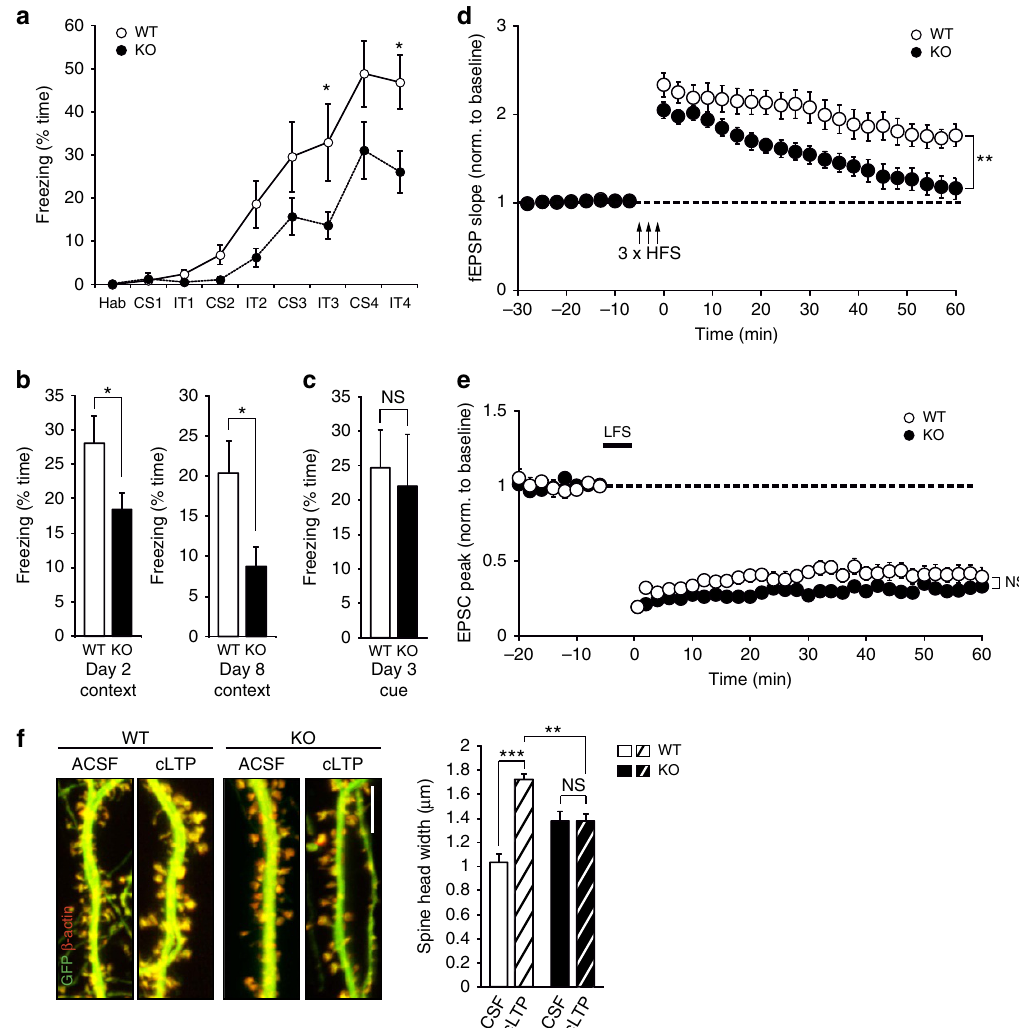
Figure 3 | Copine-6 is required for hippocampal learning and memory and synaptic plasticity. ( a – c ) Fear conditioning in WT and Cpne6 KO mice. ( a ) Freezing behaviour during training session on day 1. CS, conditioning stimulus (tone); Hab, habituation; IT, inter-training interval. * P o 0.05 by two-way ANOVA with Bonferroni post-hoc test. ( b ) Time of freezing in context test on day 2 (left) or on day 8 (right). * P o 0.05 by Student’s t -test. ( c ) Freezing in cue test (cued fear memory) on day 3 after training. NS, nonsignificant. P 4 0.05 by Student’s t- test. Data in a – c are mean ± s.e.m. from n ¼ 9 WTand 10 KO male mice of 8 to 13 weeks of age. ( d ) Extracellular field potential recordings from acute slices. LTP was induced by high-frequency stimulation (HFS). Data are mean ± s.e.m. from WT: n ¼ 9 recordings; KO: n ¼ 7 recordings (6 WT mice; 5 KO mice; age between 6 and 8 weeks). ** P o 0.01; by two-way ANOVA with Bonferroni post-hoc test. ( e ) Whole-cell patch-clamp recordings from CA1 neurons of acute slices. LTD was induced by low-frequency stimulation (LFS) and simultaneous postsynaptic depolarization. Data are mean ± s.e.m. from WT: n ¼ 9 recordings; KO: n ¼ 10 recordings (7 WT mice, 5 KO mice; age between 4 and 5 weeks). NS. P 4 0.05 by two-way ANOVA with Bonferroni post-hoc test. ( f ) DIV21 cultured hippocampal neurons isolated from WT or Cpne6 KO mice, which were transfected at DIV14 with constructs coding for b -actin-tdRFP (red) and GFP (green). Cultures were incubated with ACSF or cLTP-inducing ACSF (cLTP) for 10min and spine head width was determined after 40min. Data are mean ± s.e.m. from WT ACSF, WTcLTP, KO cLTP: n ¼ 9 neurons; KO ACSF: n ¼ 11 neurons (from 3 independent cultures per genotype). *** P o 0.001; ** P o 0.01; NS. P 4 0.05 by one-way ANOVA with Tukey’s post-hoc test. Scale bar, 10 m